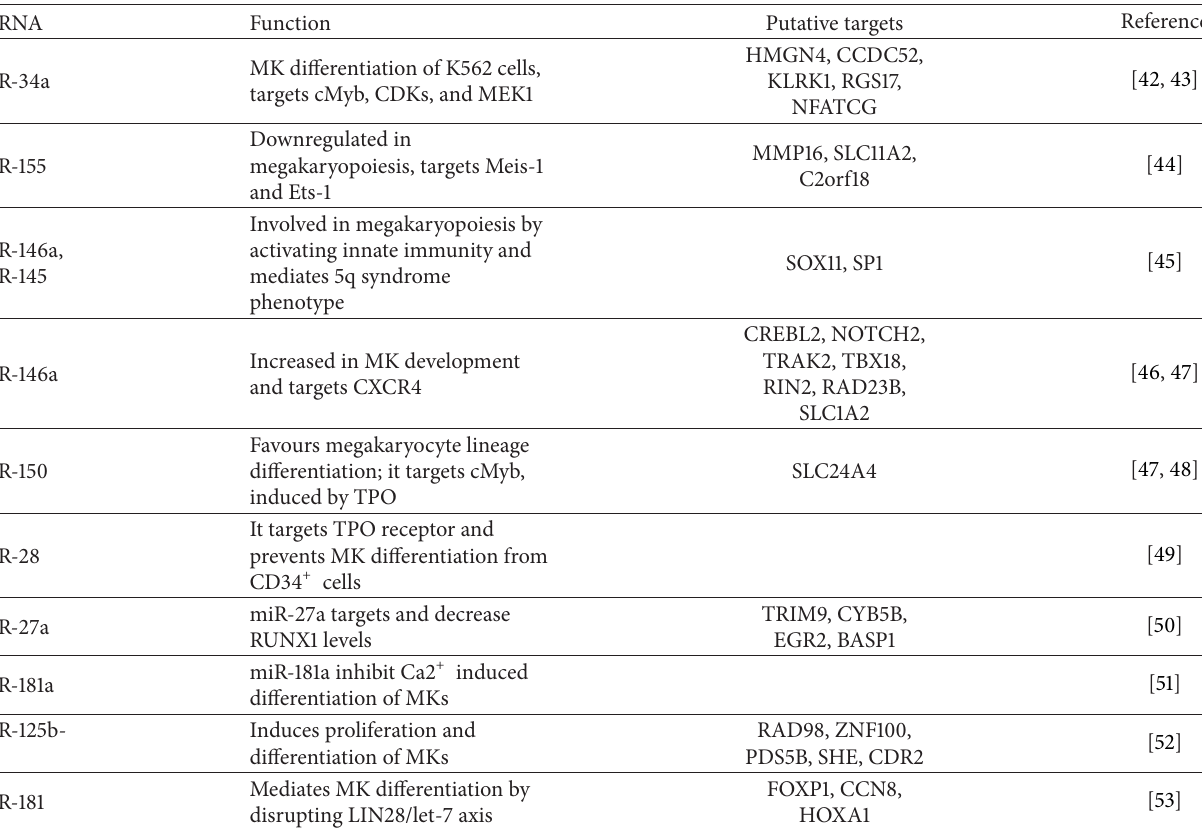
Table 4: miRNA involved in megakaryopoiesis.